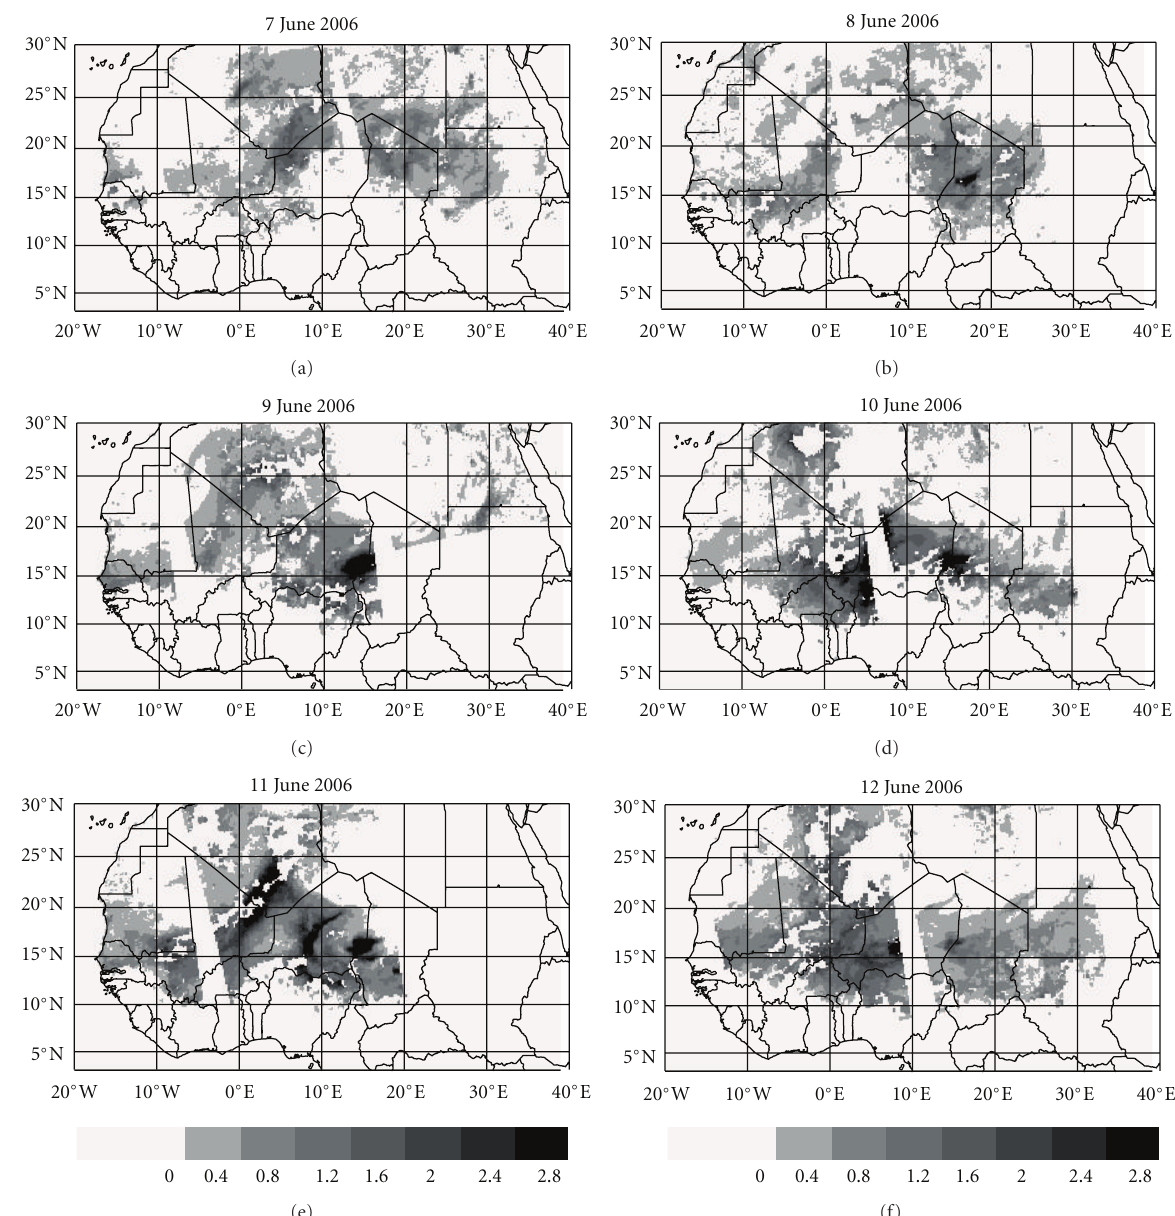
Figure 5: MODIS AOT estimates from the “Deep Blue” product [1] over north and west Africa from the 7th to 12th of June, 2006 at around 13.30 local